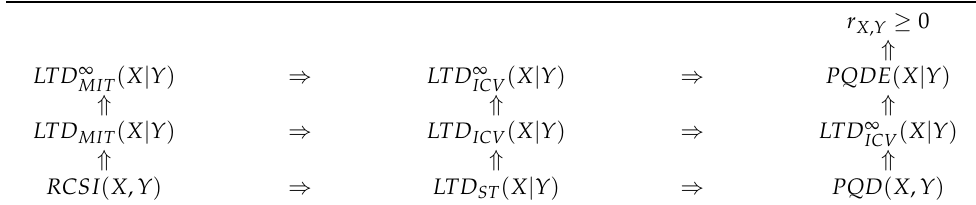
Table 7. Relationships among reversed weak dependence